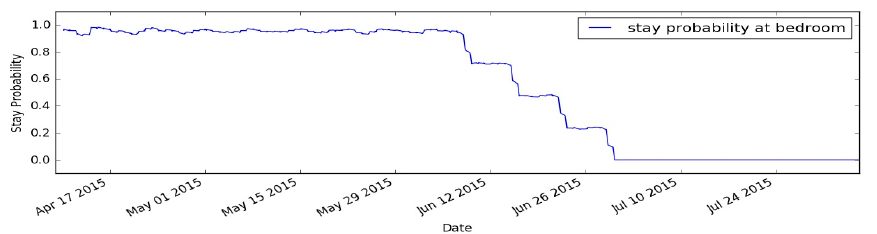
Figure 12. Model Adaptation.